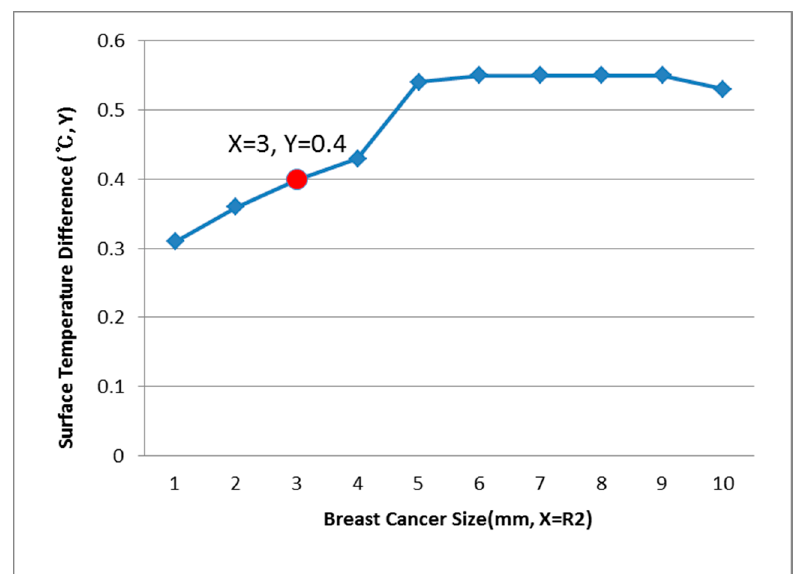
Figure 15. Surface temperature difference for an R1 of 60 mm (X = 0, Y = 10). Bioengineering 2018 , 5 , x FOR PEER REVIEW 12 of 14